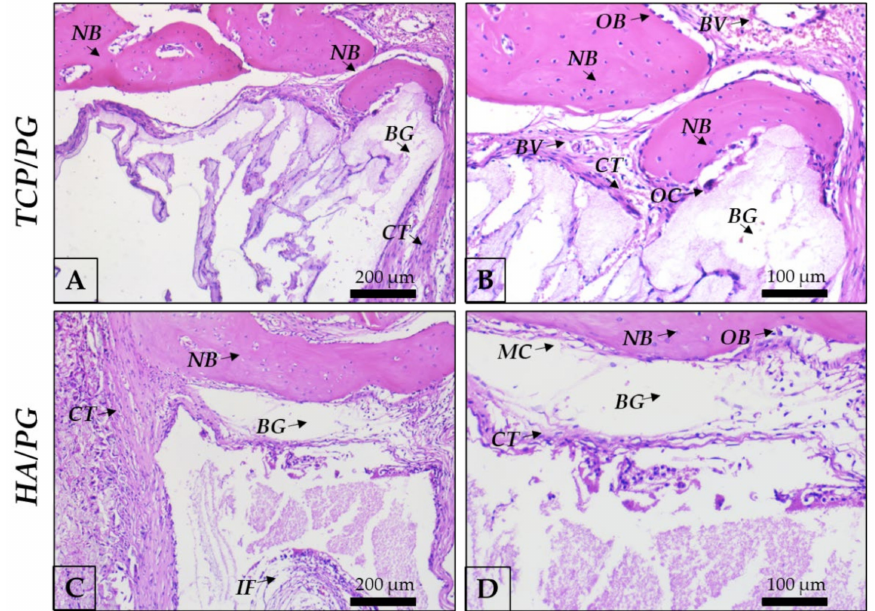
Figure 7. Representative photomicrographs of TCP/PG and HA/PG at 30 day histological